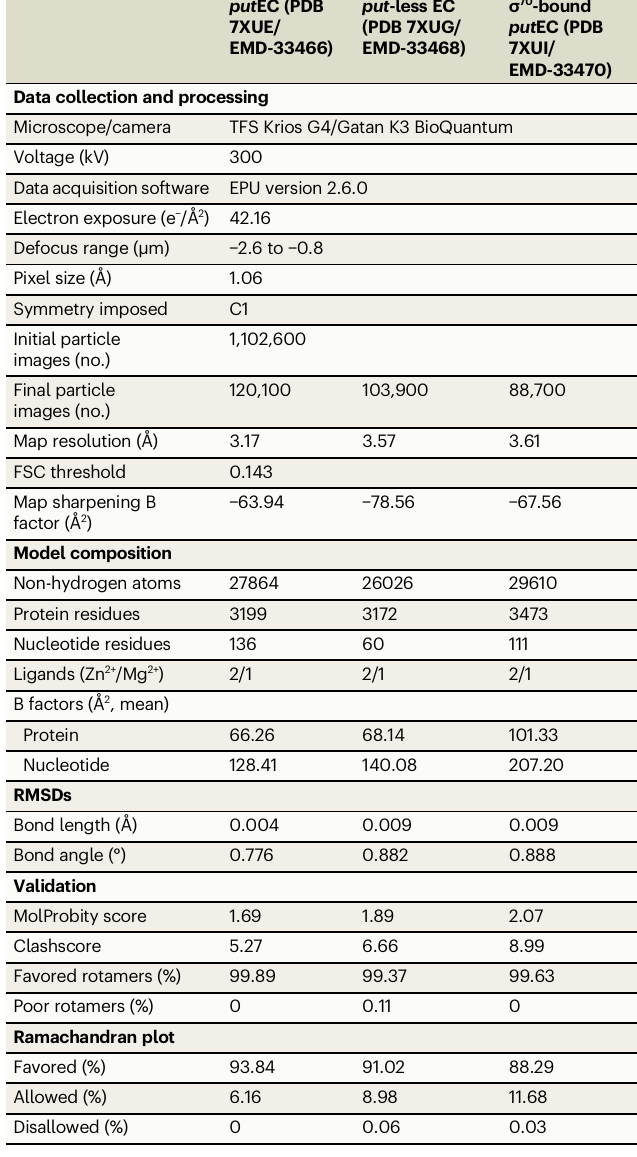
Table 1 | Cryo-EM data collections, processing, and